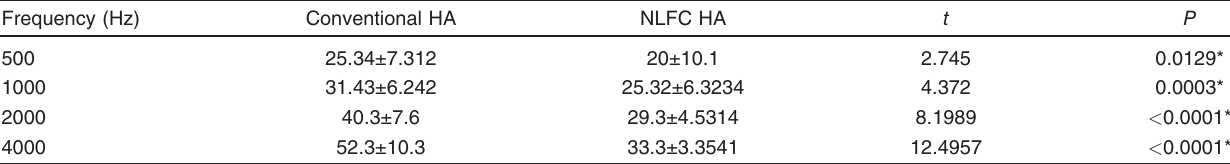
Table 3 Aided free field threshold using conventional hearing aids and nonlinear frequency compression Frequency (Hz)